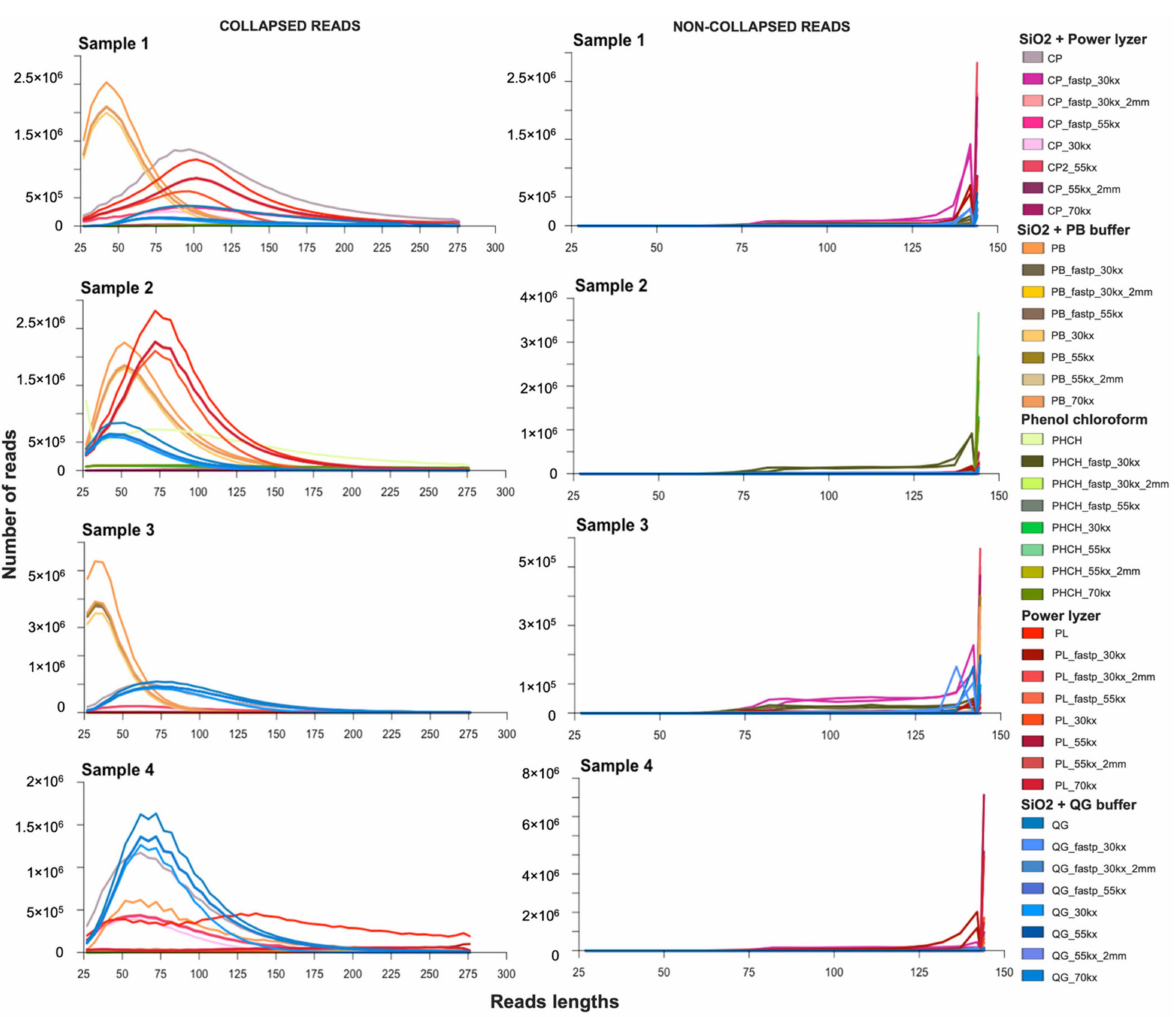
Figure 2. DNA fragment length distributions of collapsed ( left ) and non-collapsed ( right ) reads from the four samples extracted with five DNA extraction methods and preprocessed using eight bioinformatic pipelines. Each color indicates a different extraction method and